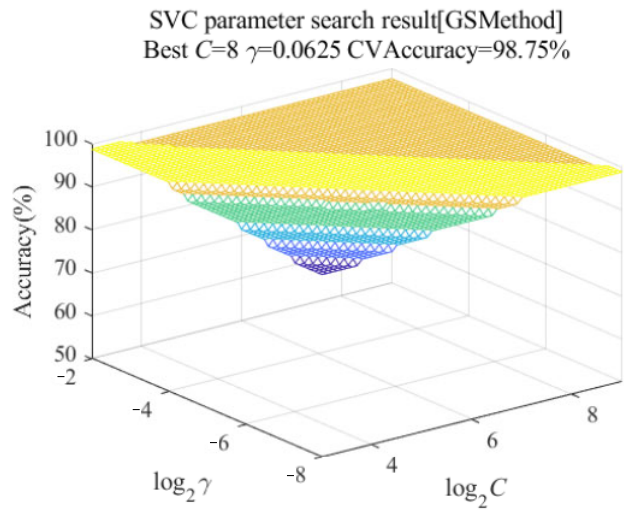
Figure 10. Parameter optimization results.